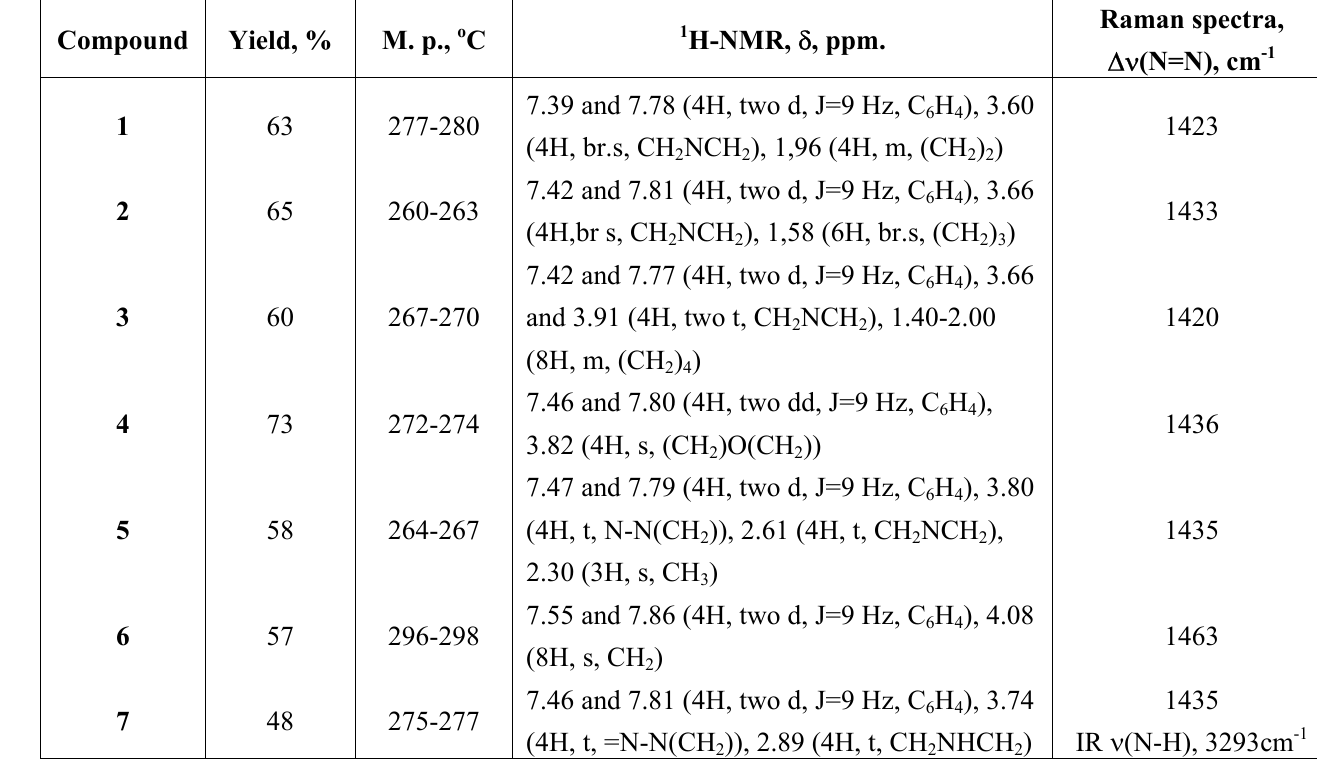
Table 1. Physical and spectral properties of the potassium salts of N,N-disubstituted aminoazobenzenesulfonic acids